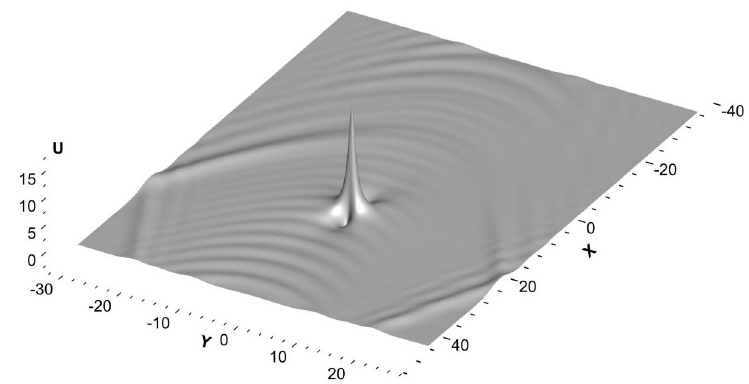
Figure 1. The e ff ects of the interaction of propagating waves without smoothing at t =